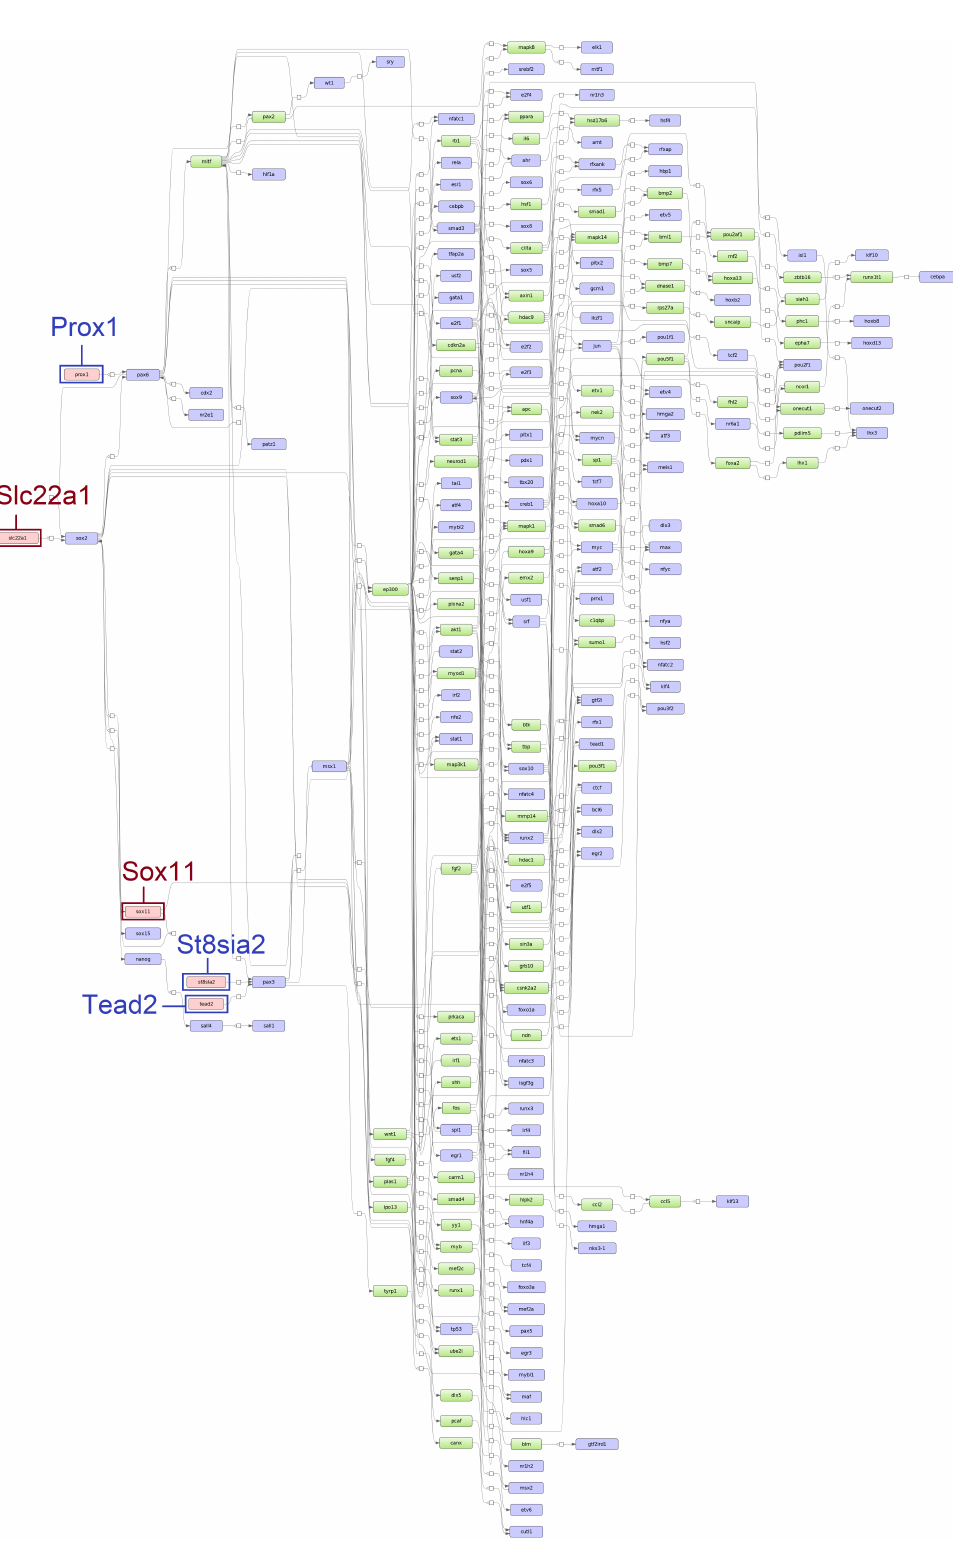
Figure 6. Scheme of gene regulatory pathways revealing the top five master regulators (pink filled boxes) for eggshell strength at Time Point 2 (ESS2) following the “upstream analysis” [42]. The master regulators written in dark blue and surrounded by dark blue boxes ( Prox1, St8sia2 and Tead2 ) were identified specifically for ESS2 while master regulators written in dark red and surrounded by dark red boxes ( Slc22a1 and Sox11 ) were identified at both time points (corresponding networks for eggshell strength at Time Point 1 (ESS1) in Figure